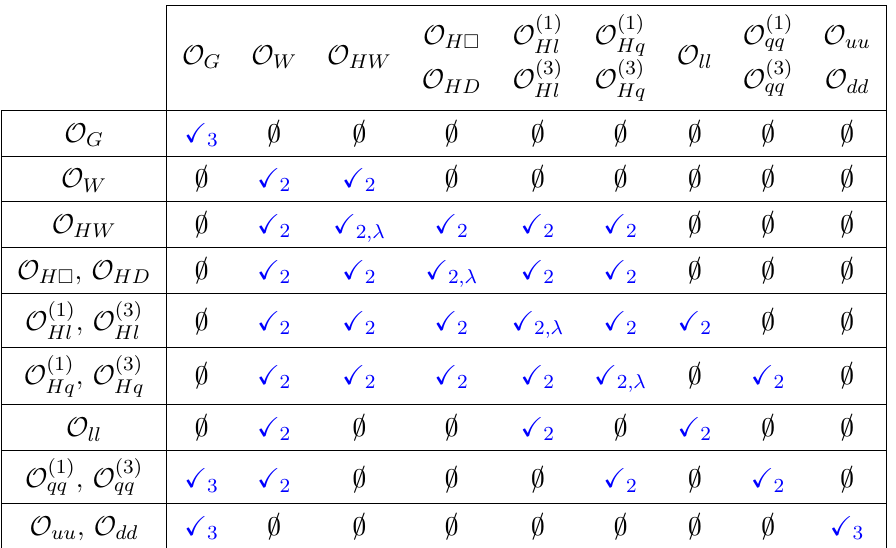
Table 5 . Checks on the one-loop anomalous dimensions calculated in refs. [4{6] obtained from our calculations. The = 0 entries correspond to trivial cases were there are no contributing